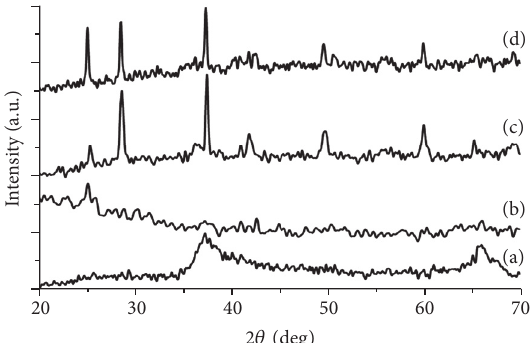
Figure 3: XRD image of MnO 2 at different temperatures: gamma-MnO 2 (a); 𝑡 = 400 ∘ C (b); 𝑡 = 600 ∘ C (c); and 𝑡 = 800 ∘ C (d).